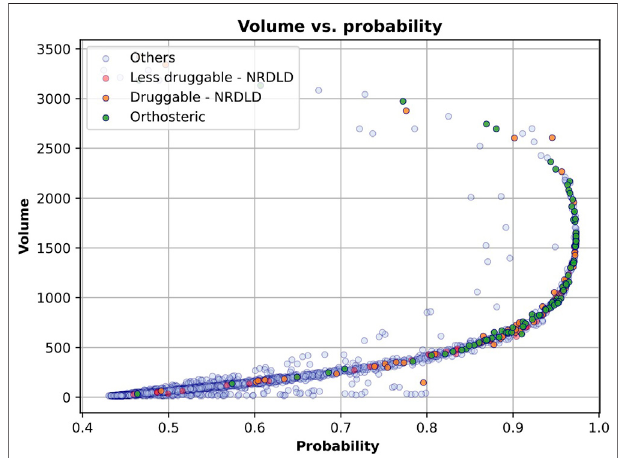
FIGURE 13 | IVDD probability scores vs. volume. Each sample represents a pocket (colored according to the corresponding dataset). The x -axis represents the probability that a pocket is druggable, while the y -axis representsthevolume ofeach pocket.Theplotisreferred tothesolution with hydrogen atoms. Similar results are obtained without hydrogen